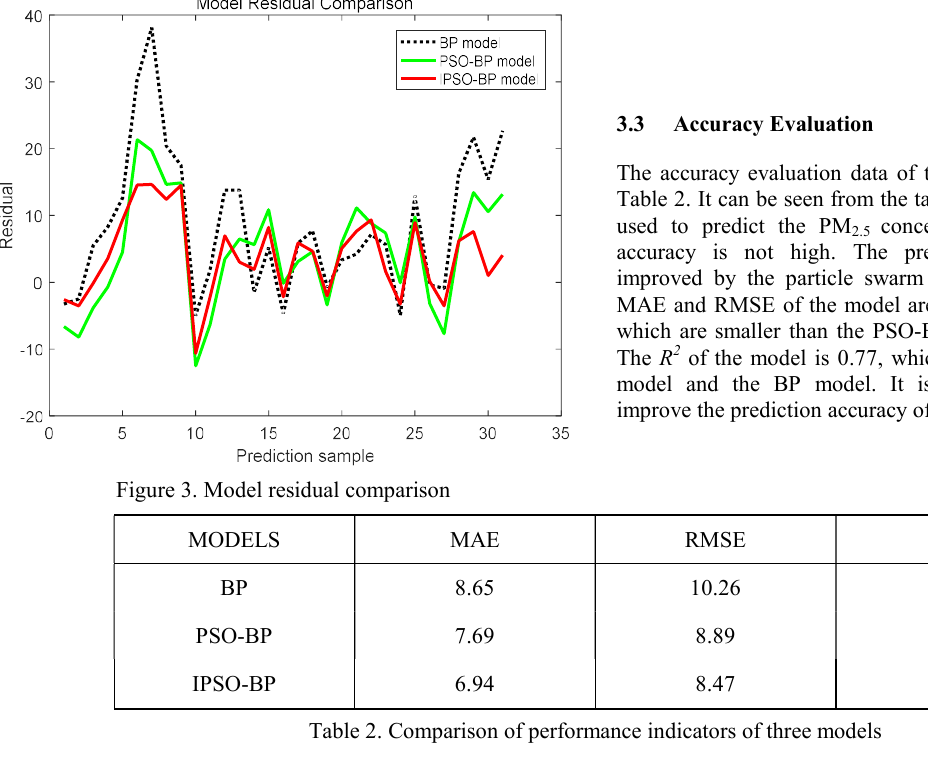
Table 2. Comparison of performance indicators of three